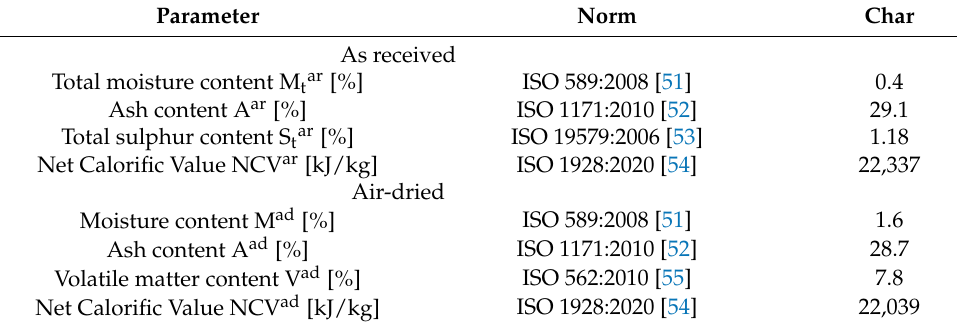
Table 4. Physico-chemical parameters of the studied char